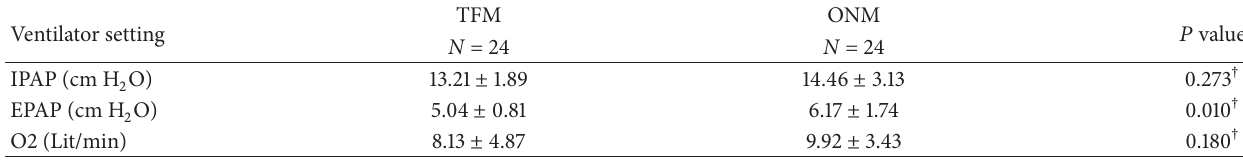
Table 6: IPAP, EPAP, and O2 requirement within the first hour in the two groups. Ventilator